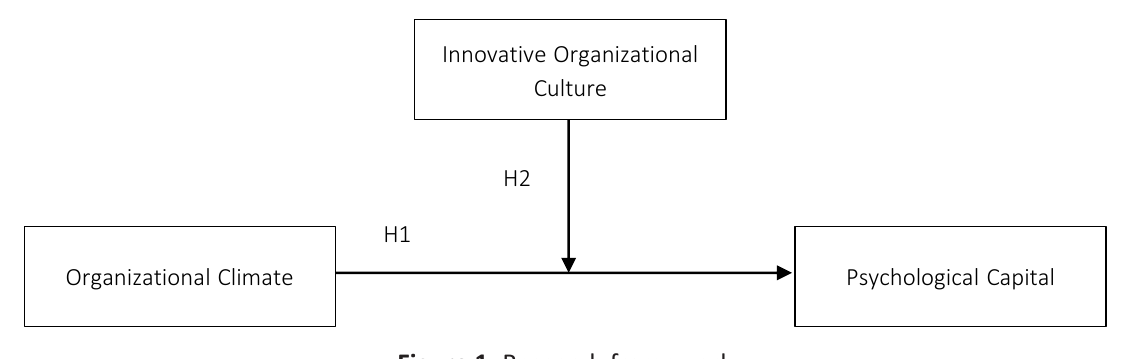
Figure 1. Research